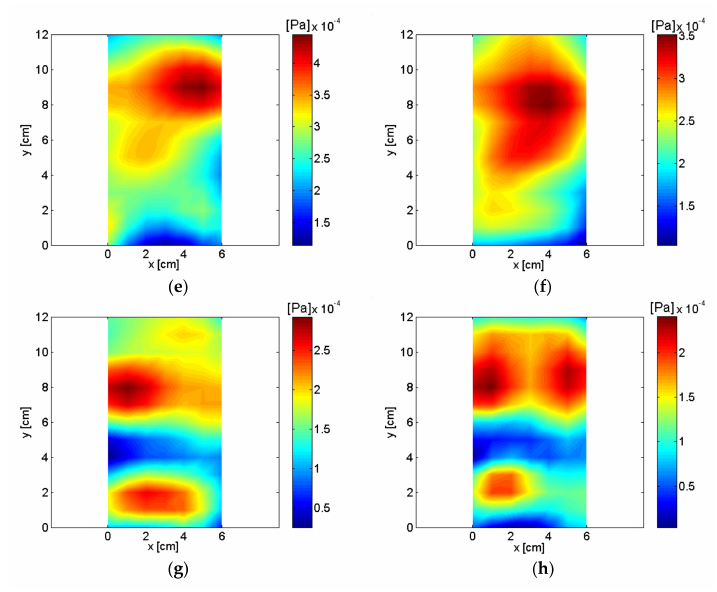
Figure 11. Reconstructed sound pressure of air compressor: ( a ) 56 Hz; ( b ) 356 Hz; ( c ) 836 Hz; ( d ) 1016 Hz;